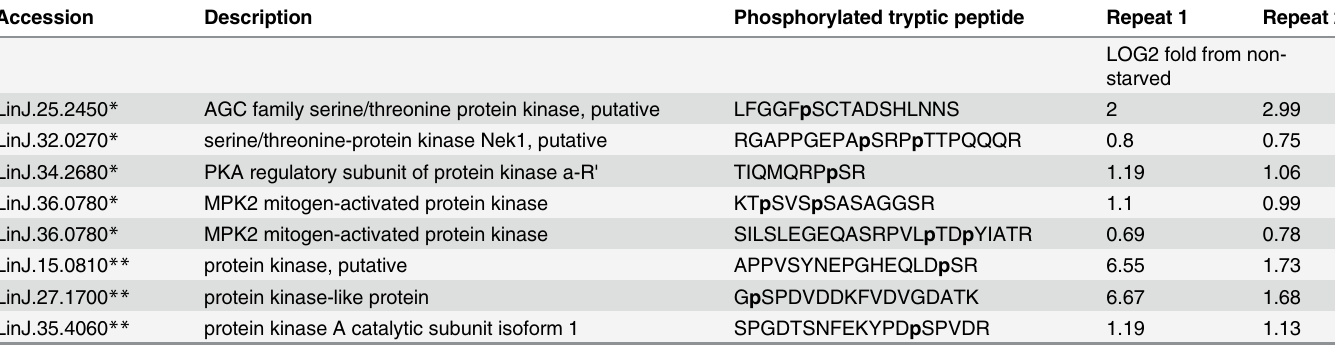
Table 2. Arginine deprivation-induced protein phosphorylation in L . donovani